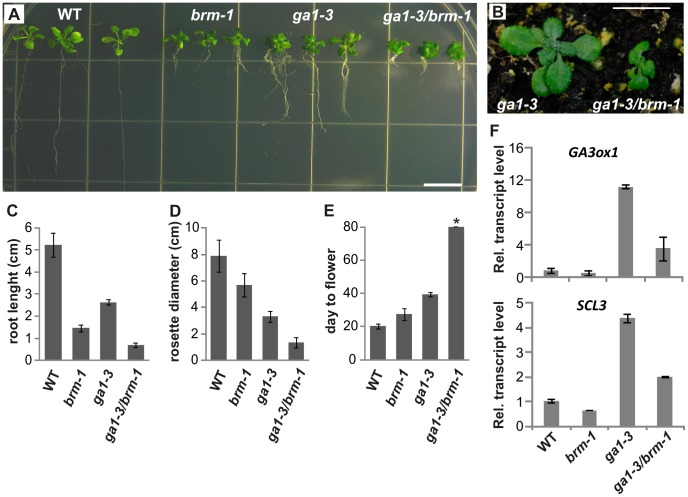

ga1-3/brm-1 mutant phenotypes.(A–B), Phenotypes of the ga1-3, brm-1 and ga1-3/brm-1 mutants grown on MS medium (18-d-old seedlings, A) or in soil (22-d-old plants, B). Bars = 10 mm. (C–F), Quantitative characterization of brm-1, ga1-3 and ga1-3/brm-1 mutants: root length of 18-d-old seedlings (C), rosette diameter at maturity (D) and flowering time under LD conditions (E). Data are the means ± s.d., 10 plants of each line were scored, except for ga1-3/brm-1 (7 plants). * All ga1-3/brm-1 plants except one failed to flower by the end of the experiment (80 days). (F), RT-qPCR analysis of relative transcript levels of GA3ox1 and SCL3 in 20-d-old wild type, brm-1, ga1-3, and ga1-3/brm-1 lines. RT-qPCR data are the means ± s.d. of 3 biological replicates. Transcript levels in the wild type were set to 1.